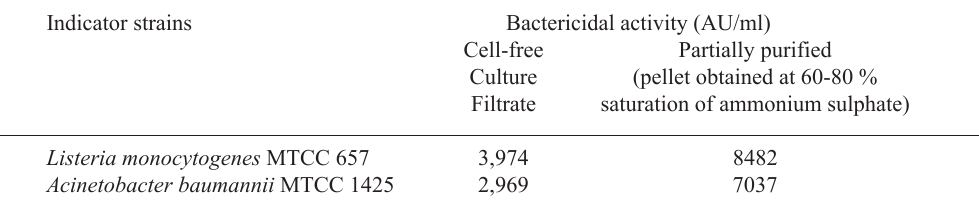
Table 3b. Activity against Listeria monocytogenes MTCC 657 Sample